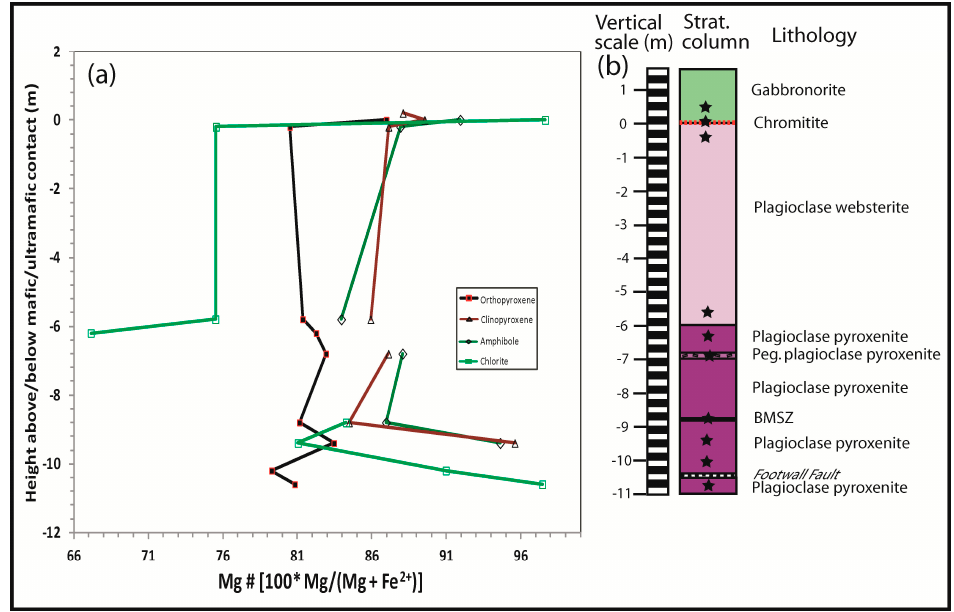
Figure 11. ( a ) Plot of Mg#s of orthopyroxene, amphibole, clinopyroxene, and chlorite versus stratigraphic height of the MSZ. Corresponding sample locations and lithologies are shown in ( b ). A total of 285 clinopyroxene analyses were performed for this study, and representative analyses are shown in Table 4 and all clinopyroxene analyses are listed in Appendix B. Clinopyroxene Mg#s range from a low of 80.7 in plagioclase websterite (sample MusWebb01/02) to a high of 99.7 in the same sample (Figure 13a,b). Across the MSZ, average clinopyroxene Mg#s also show a spiked pattern, with the highest value occurring in plagioclase pyroxenite (sample IRUP01) just above the footwall to the MSZ (Figure 11a,b). The lowest clinopyroxene Mg# value of 84.3 occurs in the base metal sulfide zone (sample MusBMSZ01) sample just above the one with the highest value, and the chromitite stringer also has a relatively high Mg# value (75.5) than samples occurring below and above it (Figure 11a,b). Clinopyroxenes from the investigated section range in composition from pigeonites through augites to diopsides (Figure 12a) and a few of the samples tend to have >50% Wo contents.